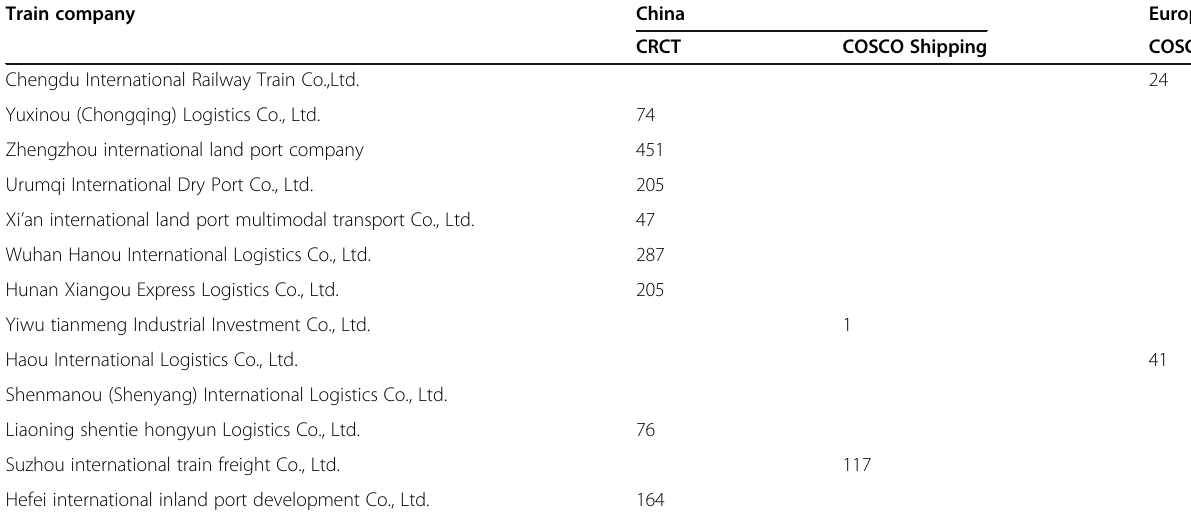
Table 4 Empty container leasing scheme (FEU) Train company